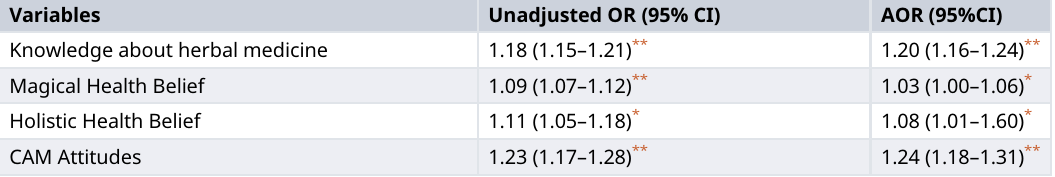
Table 3. Adjusted odds ratios (AOR) and confidence interval (%) for knowledge, magical health belief, holistic health belief, and CAM attitudes with their herbal medicine use and herbal medicine non-user during COVID-19 pandemic